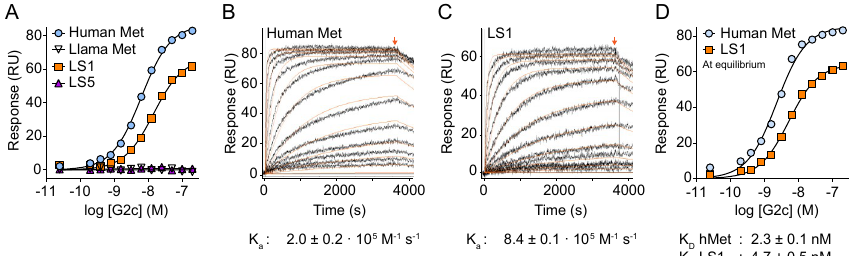
Figure 3. Binding analysis of G2c on Met using surface plasmon resonance (SPR). ( A ) Binding of G2c to wild-type human Met ectodomain and the LS1 llama/human chimera, but not the llama or the LS5 chimeric Met ectodomain proteins. ( B , C ) Representative SPR sensorgrams of the association phase and dissociation phase (8 min) (starting at arrow) of G2c binding to human Met ( B ) and LS1 chimera ( C ). Kinetic fitting is shown in orange. ( D ) Equilibrium-binding plot of G2c to human Met and LS1 chimeric variant. RU refers to response units. Kinetic parameters and equilibrium dissociation constants are the average ± SD of three independent measurements.